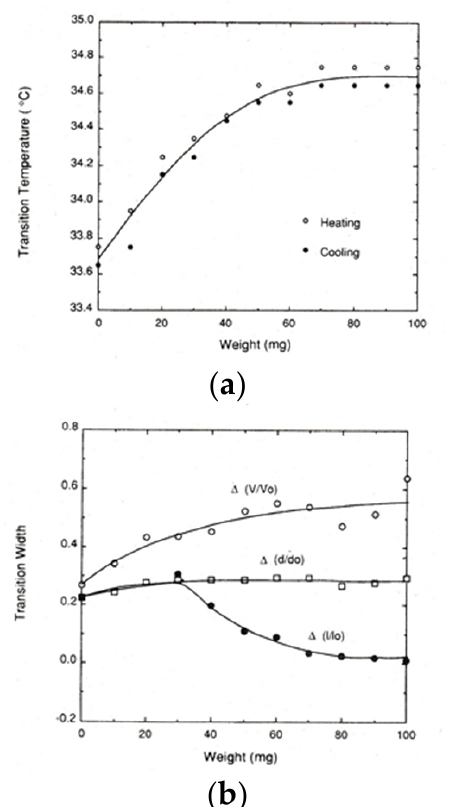
Figure 6. Uniaxial stress dependence of ( a ) the transition temperature and ( b ) the transition widths ( d / d 0 , l / l 0 and V / V 0 ) for PNIPA gels [10]. For details, see text.